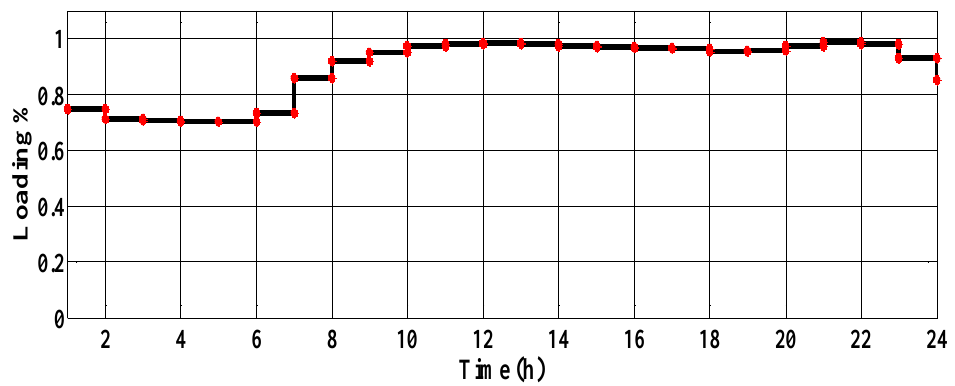
Figure 12. The gniTsacerof load profile. Figure 12. The forecasting load